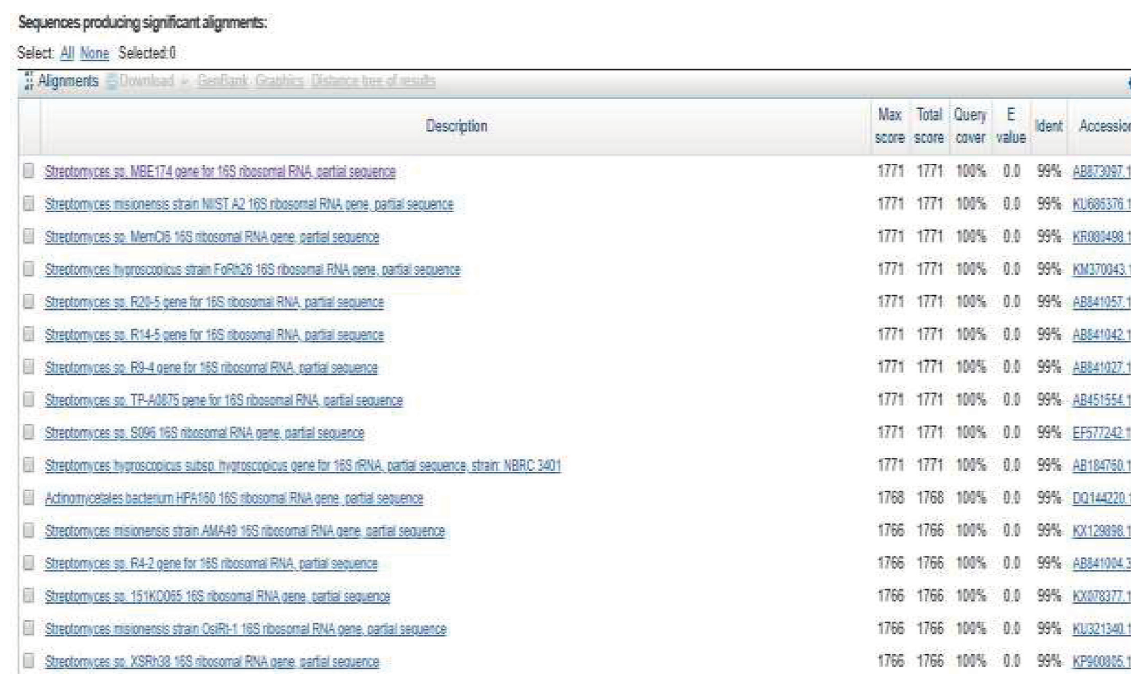
Figure 9: NCBI-BLASTn result for KDT32 16S rRNA gene